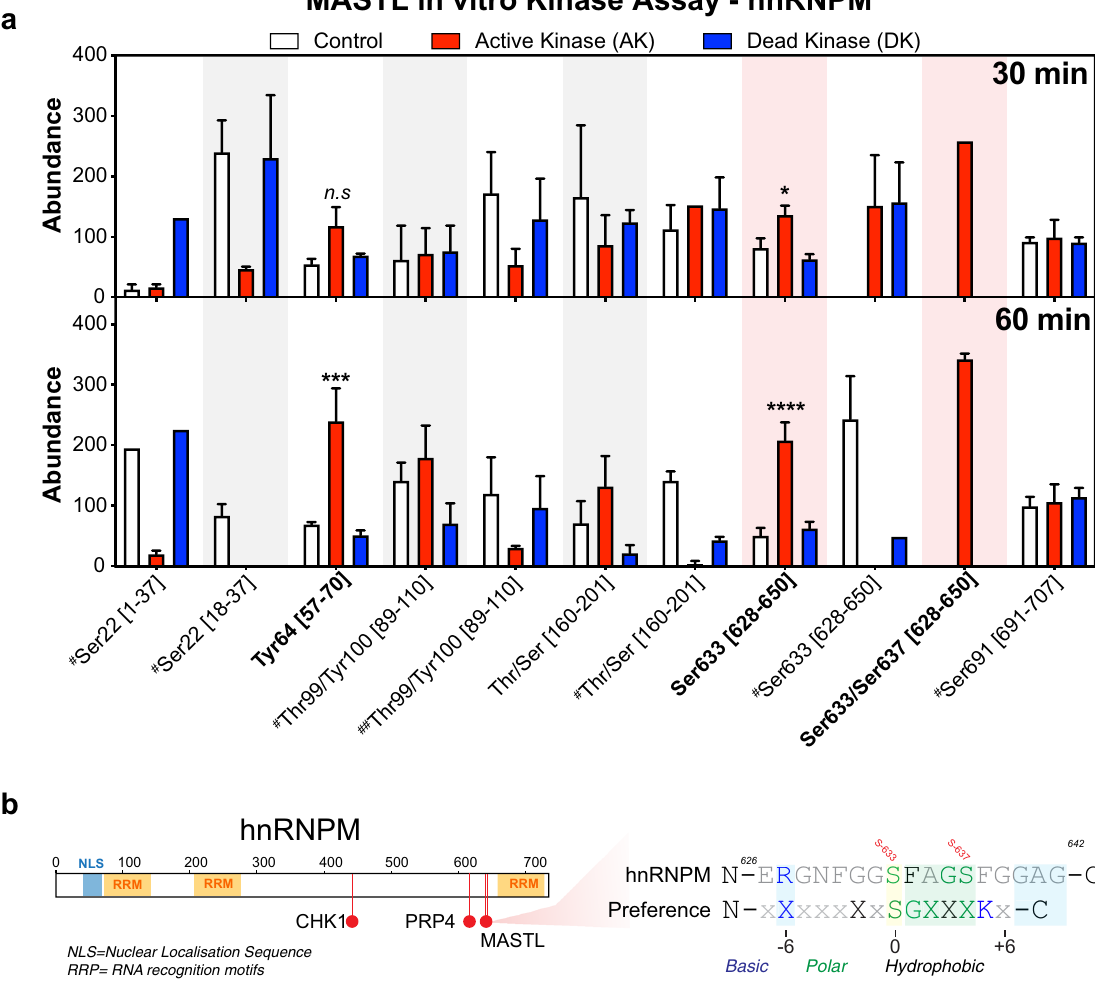
Figure 4. In vitro kinase assay validation of hnRNPM phosphorylation by MASTL. ( a ) The ion abundance of each phospho-site activated in triplicate reactions between MASTL kinase and hnRNPM (as detailed in this figure legend). Phospho-site abundances were calculated using label-free quantitation. Square brackets indicate peptide locations within the protein on which each phospho-site is found. Single hashtags denote a co-modification within that peptide, e.g., carbamidomethylation, deamidation, and/or oxidation. Double hashtags denote a different combination of co-modifications within the same peptide (detailed in Supplementary Table S7). Error bars display the standard error of the mean from three (n = 3) independent reactions. (b) Schematic of hnRNPM showing nuclear localisation domain (NLS) RNA recognition motifs (RRM) and phospho-sites currently annotated in PhosphoSitePlus (Chk1 and PRP4) along with the novel MASTL sites identified here. Sequence alignments of the MASTL phosphorylation sites within hnRNPM (S-633 and S-637), compared to validated substrates Arpp19/ENSA and the possible MASTL motif identified from our SILAC screen (Fig.